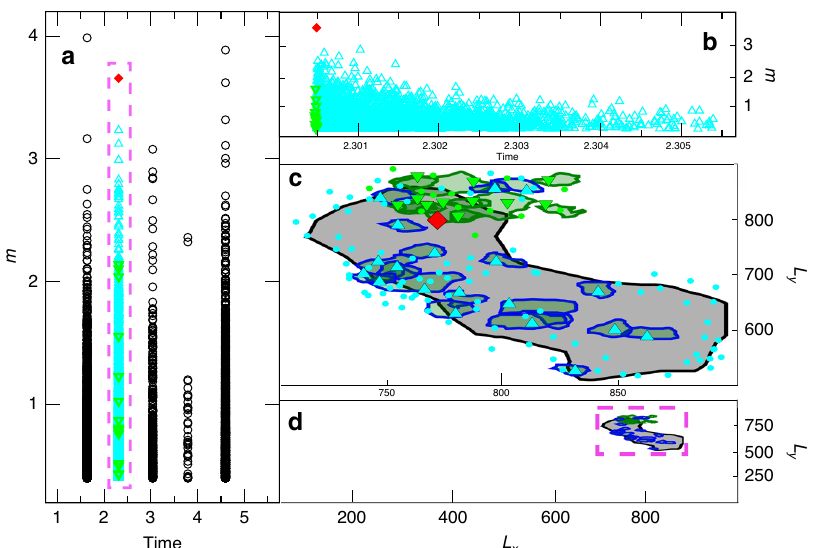
Fig. 2 The numerical catalog. a A typical example of a part of the simulated catalog containing fi ve sequences. We plot the magnitude of each event m versus its occurrence time in units of t d . b A zoom on the second sequence plotted in panel ( a ). c We plot the contour of the area fractured by the mainshock (black line) of the m > 1.5 aftershocks (blue lines) and foreshocks (green lines) for the sequence plotted in panel ( b ). Red rhombus, cyan, and green triangles indicate the hypocentral location of the mainshock, of the m < 1.5 aftershocks and foreshocks, respectively. We include only aftershocks up to the time t = 0.2 t R after the mainshock occurrence. d As in panel ( c ) for the whole fault plane, during the temporal window of the sequence considered in panel ( b ).